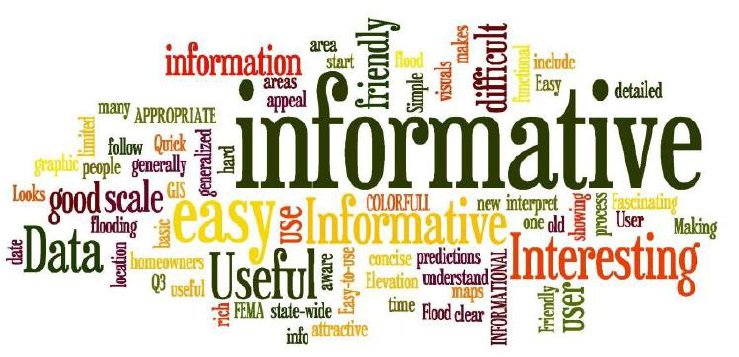
Figure 5. The word cloud created from the most commonly used answers to a summative evaluation question asking for “characteristics that describe” NJFloodMapper .